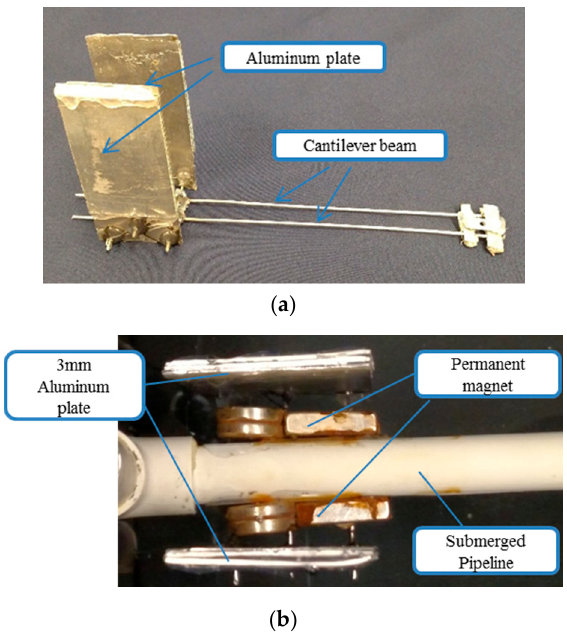
Figure 9. Implementation of the eddy current tuned mass damper (ECTMD) on the pipeline model: ( a ) configuration of ECTMD; ( b ) eddy current damper device.